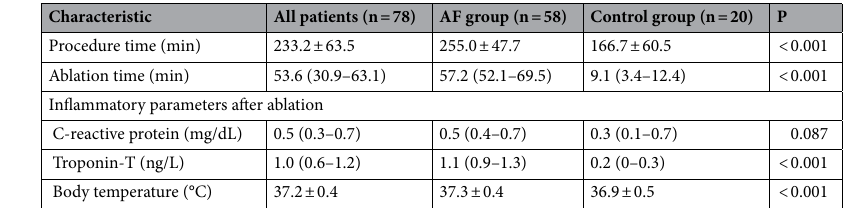
Table 2. Procedural characteristics. AF atrial